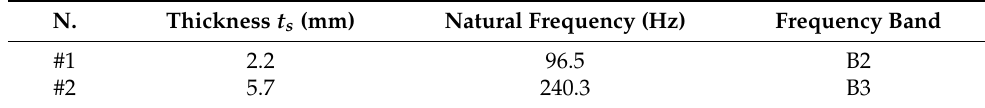
Table 4. Thickness and natural frequency of the cantilever harevsters.